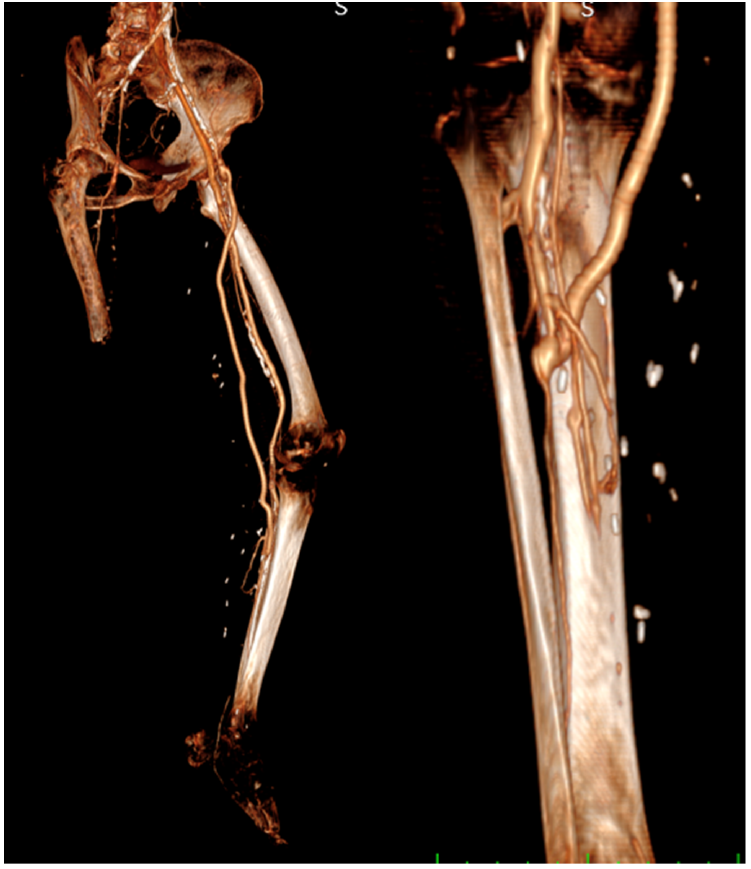
Figure 3. CT angiography .